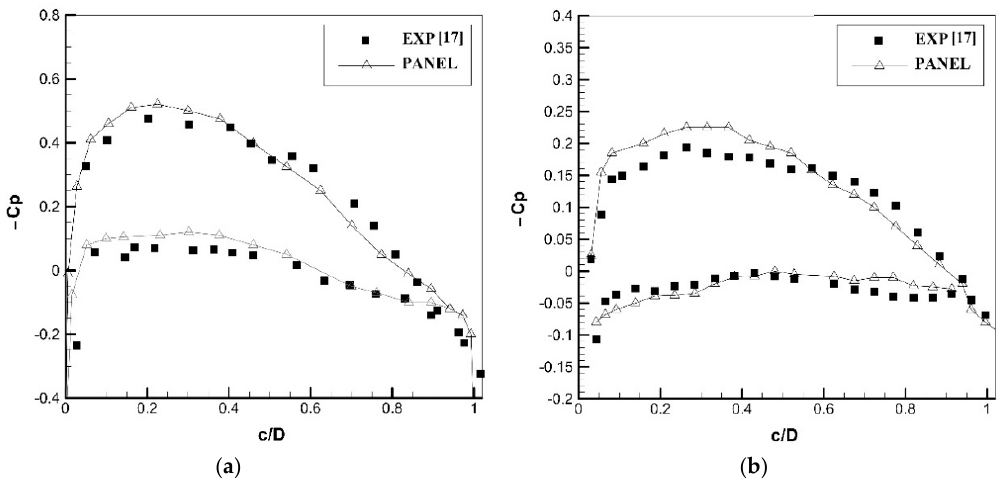
Figure 8. Experimental and panel method results for pressure distribution at ( a ) r / R = 0.3 and ( b ) r / R = 0.7.